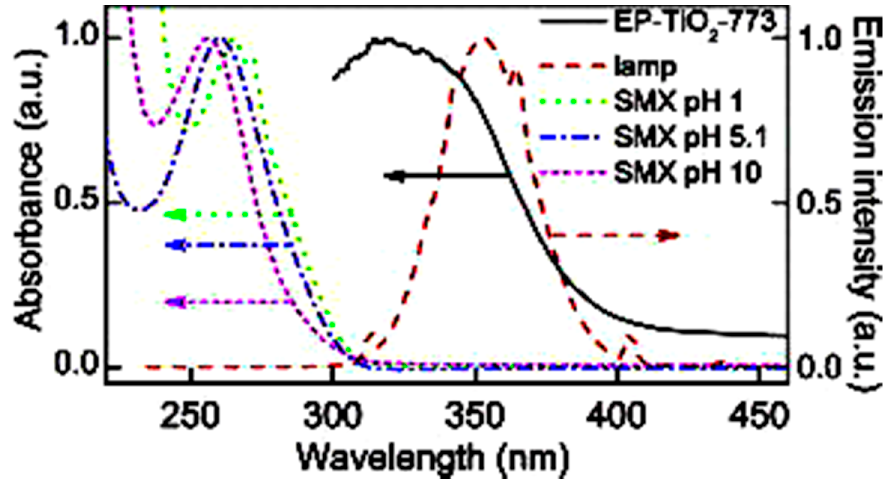
Figure 2. Variations in the wavelength absorbance by SMX with the change in the pH of the aqueous solution (reproduced from [64], Copyright Year 2015, Journal of Hazardous Material @ Elsevier with the permission order number: 5114720328428) (EP-TiO 2 : Expanded perlite coated TiO 2 particles) .